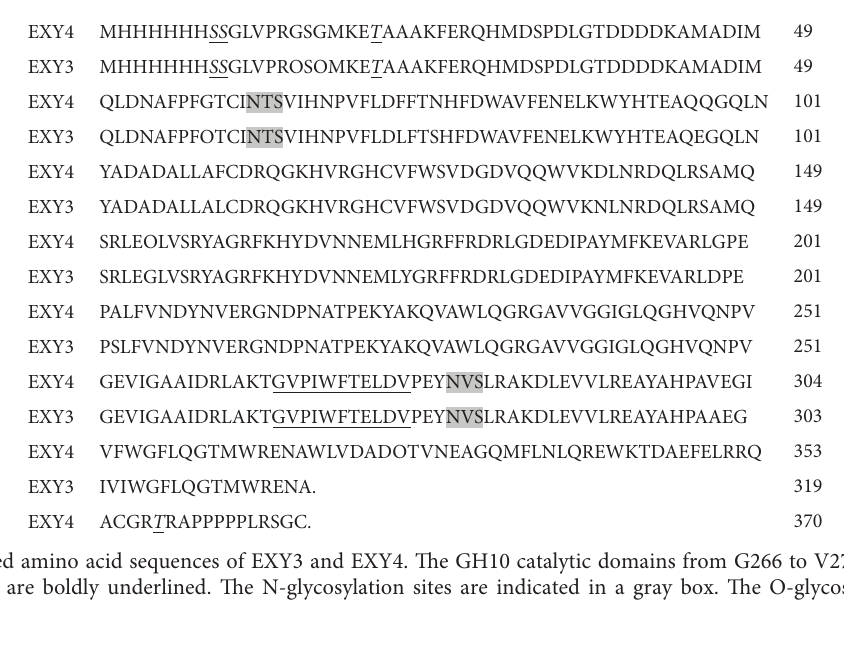
Figure 2: The deduced amino acid sequences of EXY3 and EXY4. The GH10 catalytic domains from G266 to V276 are underlined. The catalytic sites Glu273 are boldly underlined. The N-glycosylation sites are indicated in a gray box. The O-glycosylation sites are italic underlined.